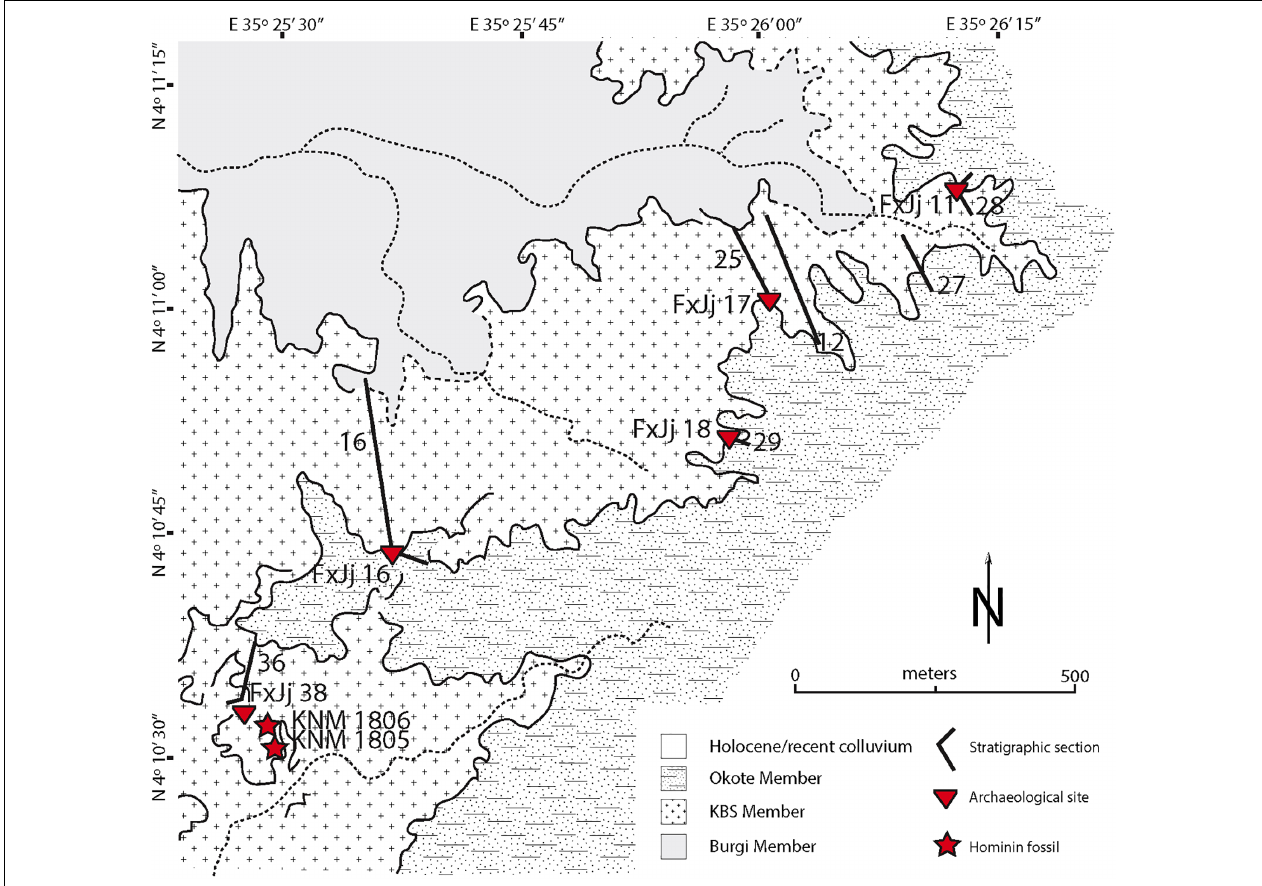
FIGURE 2 | Detailed map after Frank (1976) and Lepre (2017) highlighting the distribution of the various stratigraphic sections studied as well as the location of the major archeological sites and hominin fossils within the area. Stratigraphic sections match the ones described in Figure 3 . GPS coordinates for the top of the stratigraphic sections of interest are as follow: 28 (4 ◦ 11 (cid:48) 5.28 (cid:48)(cid:48) N, 36 ◦ 26 (cid:48) 9.66 (cid:48)(cid:48) E), 27 (4 ◦ 11 (cid:48) 0.06 (cid:48)(cid:48) N, 36 ◦ 26 (cid:48) 8.16 (cid:48)(cid:48) E), 12 (4 ◦ 10 (cid:48) 57.06 (cid:48)(cid:48) N, 36 ◦ 26 (cid:48) 1.74 (cid:48)(cid:48) E), 25 (4 ◦ 10 (cid:48) 59.10 (cid:48)(cid:48) N, 36 ◦ 25 (cid:48) 58.56 (cid:48)(cid:48) E), 29 (4 ◦ 10 (cid:48) 50.82 (cid:48)(cid:48) N, 36 ◦ 25 (cid:48) 56.22 (cid:48)(cid:48) E), 16 (4 ◦ 10 (cid:48) 44.76 (cid:48)(cid:48) N, 36 ◦ 25 (cid:48) 36.96 (cid:48)(cid:48) E), and 36 (4 ◦ 10 (cid:48) 35.09 (cid:48)(cid:48) N, 36 ◦ 25 (cid:48) 28.76 (cid:48)(cid:48) E). Solid black lines represent traces of outcrops. Dashed lines are inferred continuation of outcrop traces. Dotted lines are major ephemeral streams flowing generally toward the